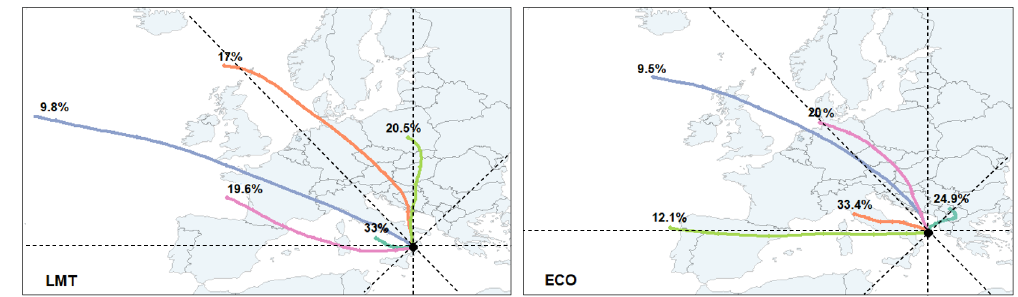
Figure 8. Cluster centroids retrieved from the 3d analytical back trajectories reaching ECO and LMT at 500ma.s.l. The maps were plotted using HYSPLIT integrated with the openair